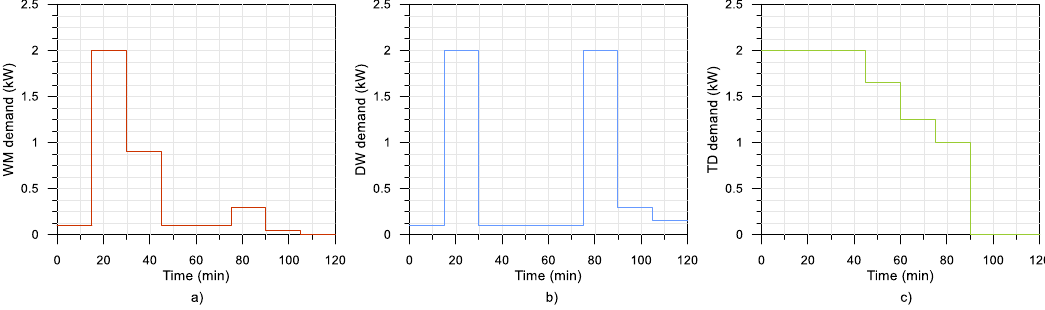
Figure 4. Smart appliances (SA) models employed in the optimization: a ) Washing machine demand, b ) dishwasher demand, and c ) tumble drier demand.